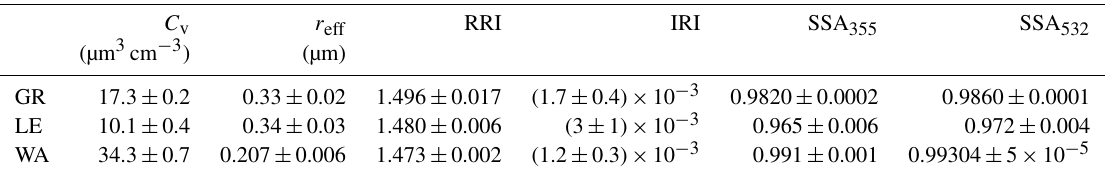
Figure 7. Position (altitude, latitude and longitude) and type of the aerosol layers detected by CALIPSO for each of the overpasses tracking the masses arriving at Granada and Leipzig (depicted in Fig. 5 as 8–15), with black color indicating smoke aerosol particles. Table 4. Average particle microphysical properties (namely volume concentration, effective radius, real and imaginary part of refractive index, and single scattering albedos) for the same selected thin layers within the smoke zone. The associated uncertainty for each variable corresponds to the standard deviation from the average